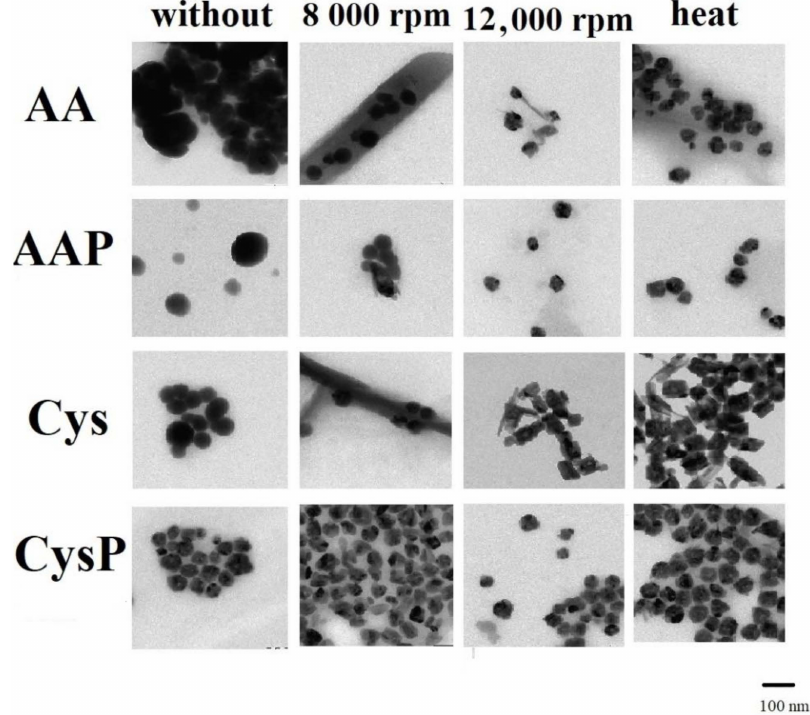
Figure 7. TEM images of the obtained